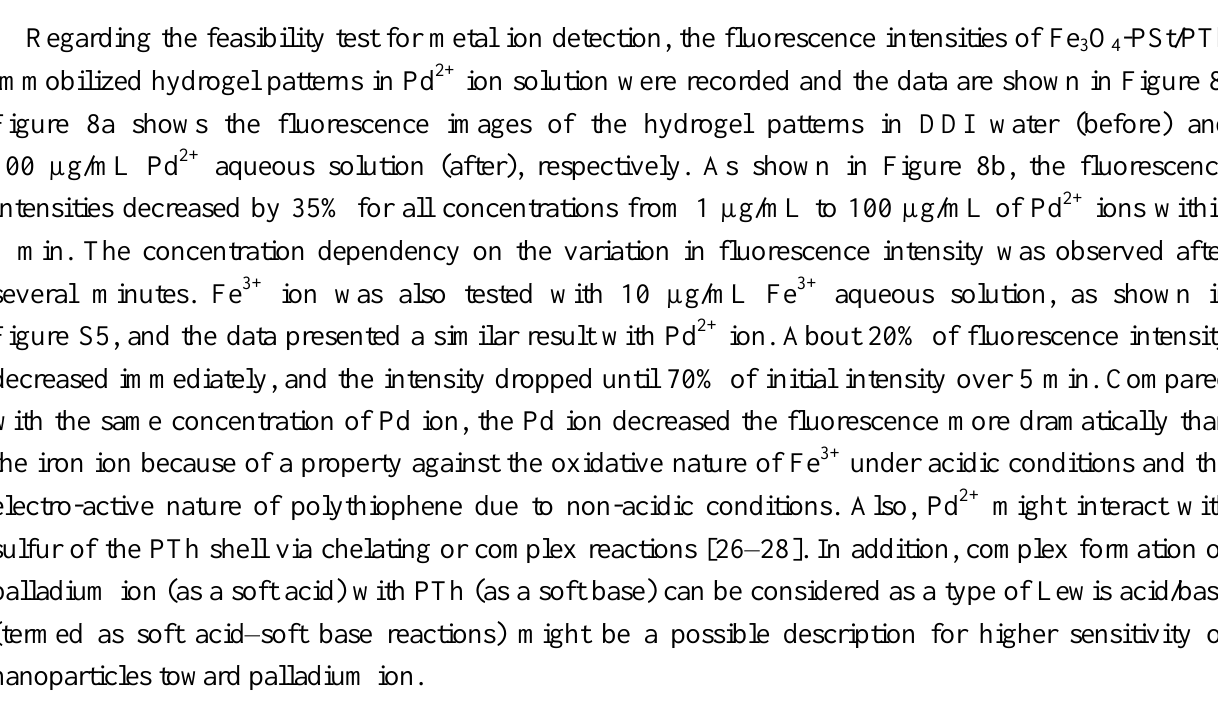
O -PSt/PTh immobilized hydrogel pattern in 3 4